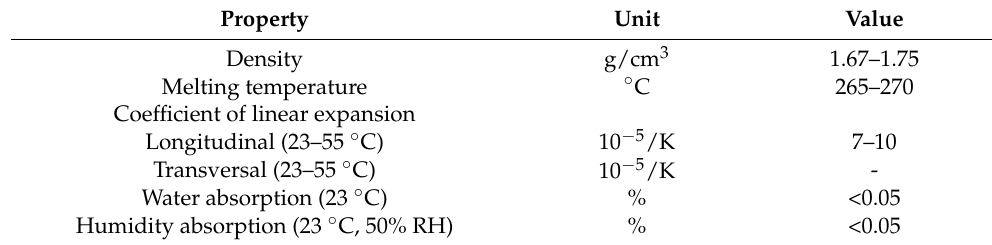
Table 1. Exemplary physical and chemical properties of ETFE copolymer [23].